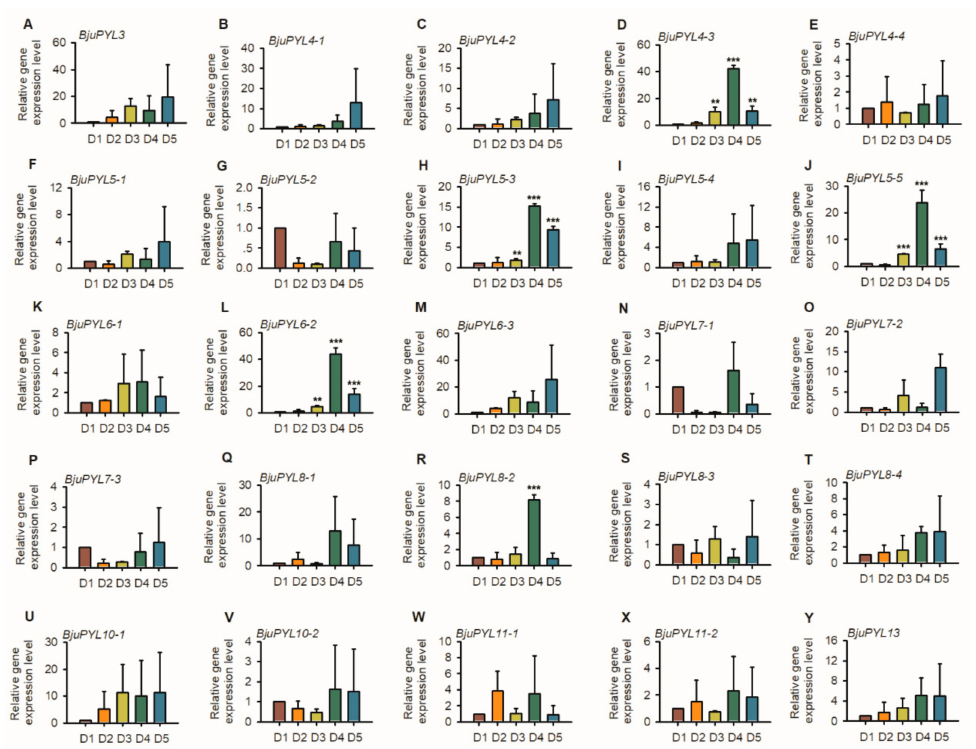
Figure 8. The expression patterns of BjuPYLs at di ff erent stages of stem swelling. Total RNA was extracted from the seedlings of D1, D2, D3, D4, and D5 stages. Data were normalized to the expression level of BjuActin3 . The values are means ± standard error. Three independent biological repeats were